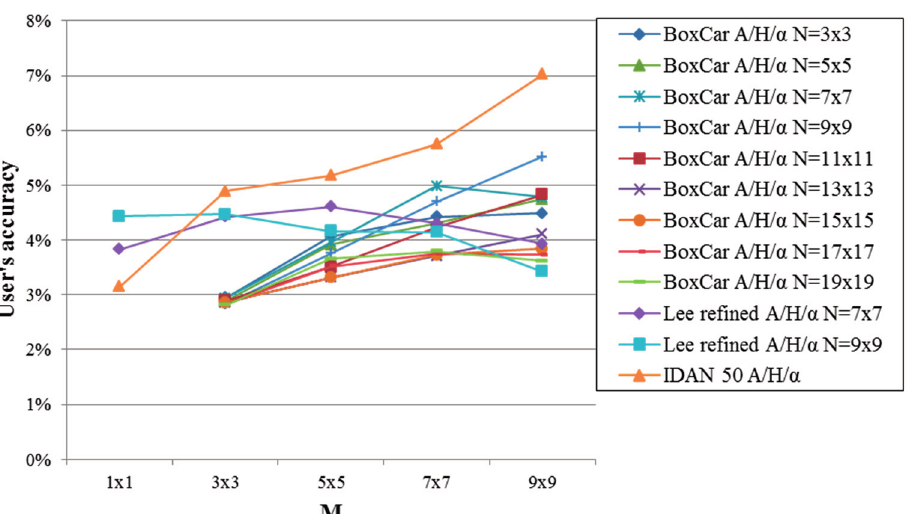
Figure 7. User’s accuracy vs. window size M after the pixel-based PolSAR classification based on A/H/ α (box car, refined Lee and IDAN filter) for the first TerraSAR-X acquisition (5 September